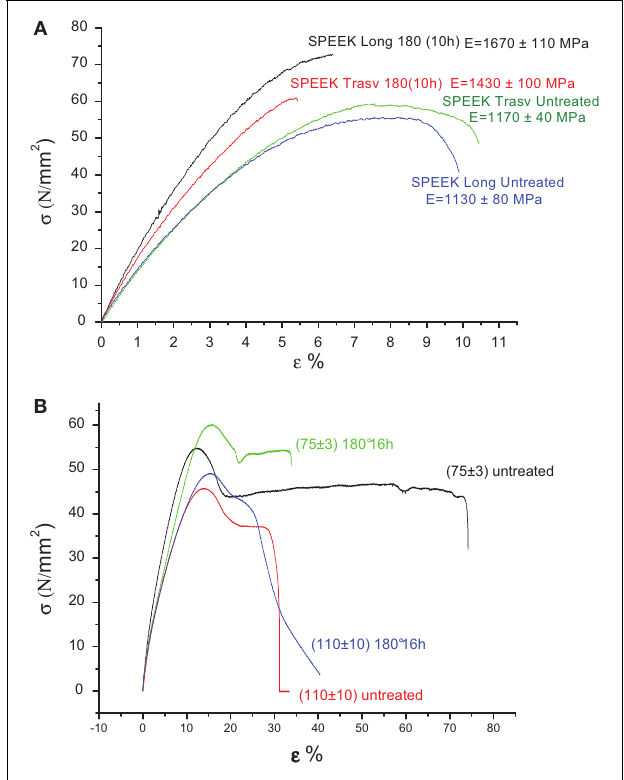
FIGURE 3 | (A) Effect of the casting direction (longitudinal or transversal) and (B) effect of thickness (micrometer) on stress-strain curves of SPEEK membranes are shown.